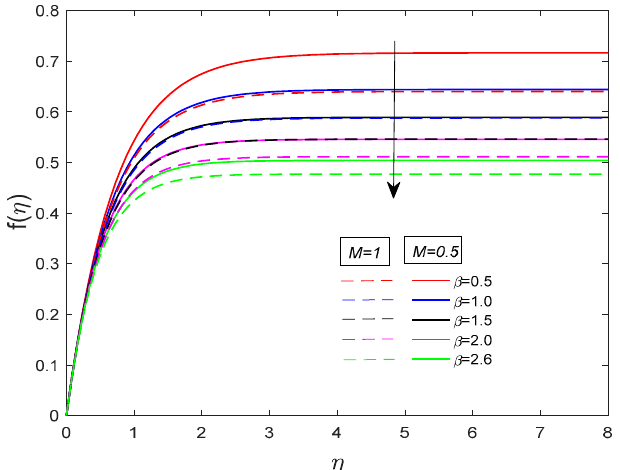
Figure 6. Effect of Maxwell fluid parameter ( β ) on normal velocity profile with Pr = Sc = 0.7, Ec = Kr = Sr = 0.1.